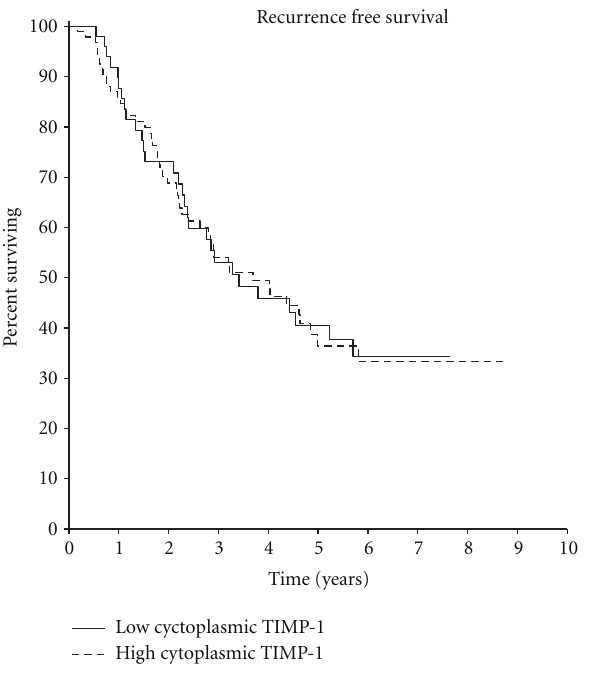
Figure 4: (HR = 1 . 0 P = 0 . 92). Figure 5: (HR = 1 . 41 P = 0 .